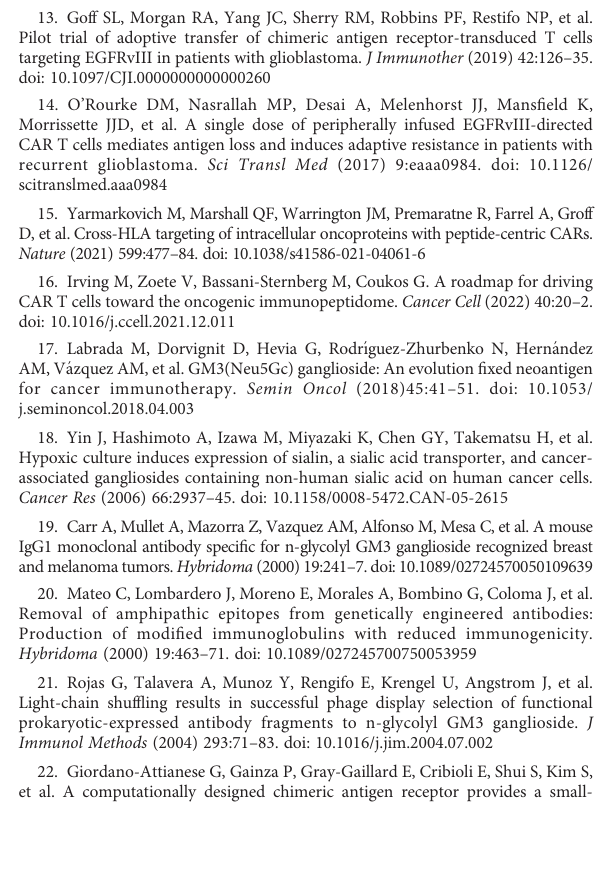
SUPPLEMENTARY FIGURE 2 (A) Weight of female and male mice over time for in vivo toxicity study (treated as per Figure 3A). (B) Flow cytometric analysis to evaluate NGcGM3 expression by 14F7 mAb staining of dissociated lungs (in purple) and SKOV3 CMAH cells (in red) compared to control (secondary Ab alone, in grey). (C) Flow cytometric analysis to evaluate NGcGM3 expression by14F7mAbstaining fordifferentdissociated organs (in red) compared to control (secondary Ab alone, in grey). (D) Histopathology of the organs [treated as per Figure 3A): H&E = hematoxylin and eosin staining at 100X and 400X magni fi cation; IHC = immunohistochemistry to detect GFP + T cells (brown, indicated with arrow)]. (E) Quanti fi cation of GFP + and F4/80 + cells in different organs evaluated by IHC (treated as per Figure 3A). (F) Flowcytometric analysis of dissociated organs and peripheral blood (mice treated as per Figure 3A) to detect human CD8 + (left) and CD4 + (right) T cells. Shown is average ± sem (A) , ± SD (E) . Statistical analysis unpaired two-tailed t test (E) . (****p<